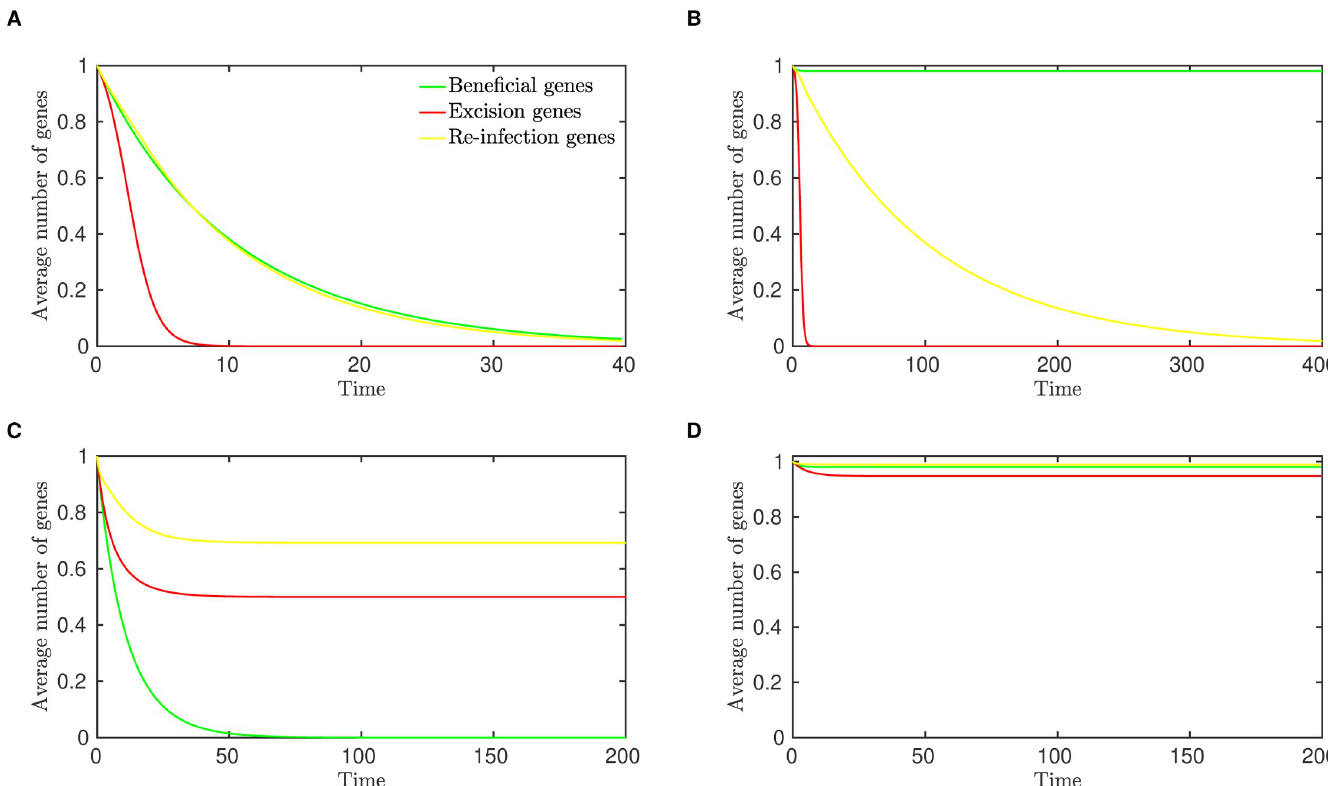
Fig 3. Numerical integration of the analytical model, showing the system of equations (Eq 1) converging toward four possible equilibria: (A) Extinction , E 0 ( r 0.01, r D = 0.1, r L = 0.2). (B) Domestication , E B ( r S = 0.52, r D = 0.01, r L = 0.2). (C) Parasitism , E ER ( r S = 0.02, r D = 0.1, r L = 1.3). (D) Persistence , E A ( r S = 0.52, r D = 0.01, r L = 1.2). In all cases, r = 1. I